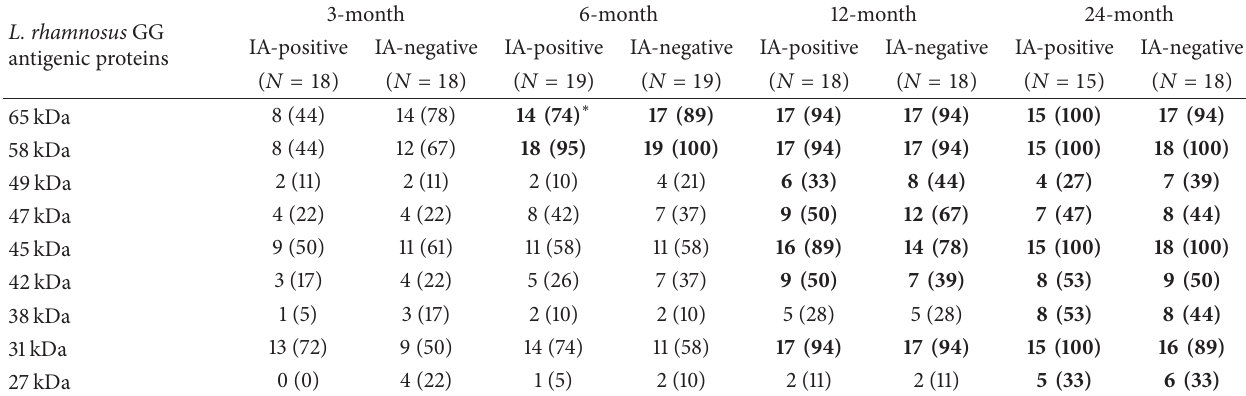
Table 2: The number of children in different age groups with serum IgG reactivity to different L. rhamnosus GG proteins. The age period when significantly more ( 𝑃 < 0.05 ) antibodies against bacterial proteins were observed compared to the 3-month age group is shown in